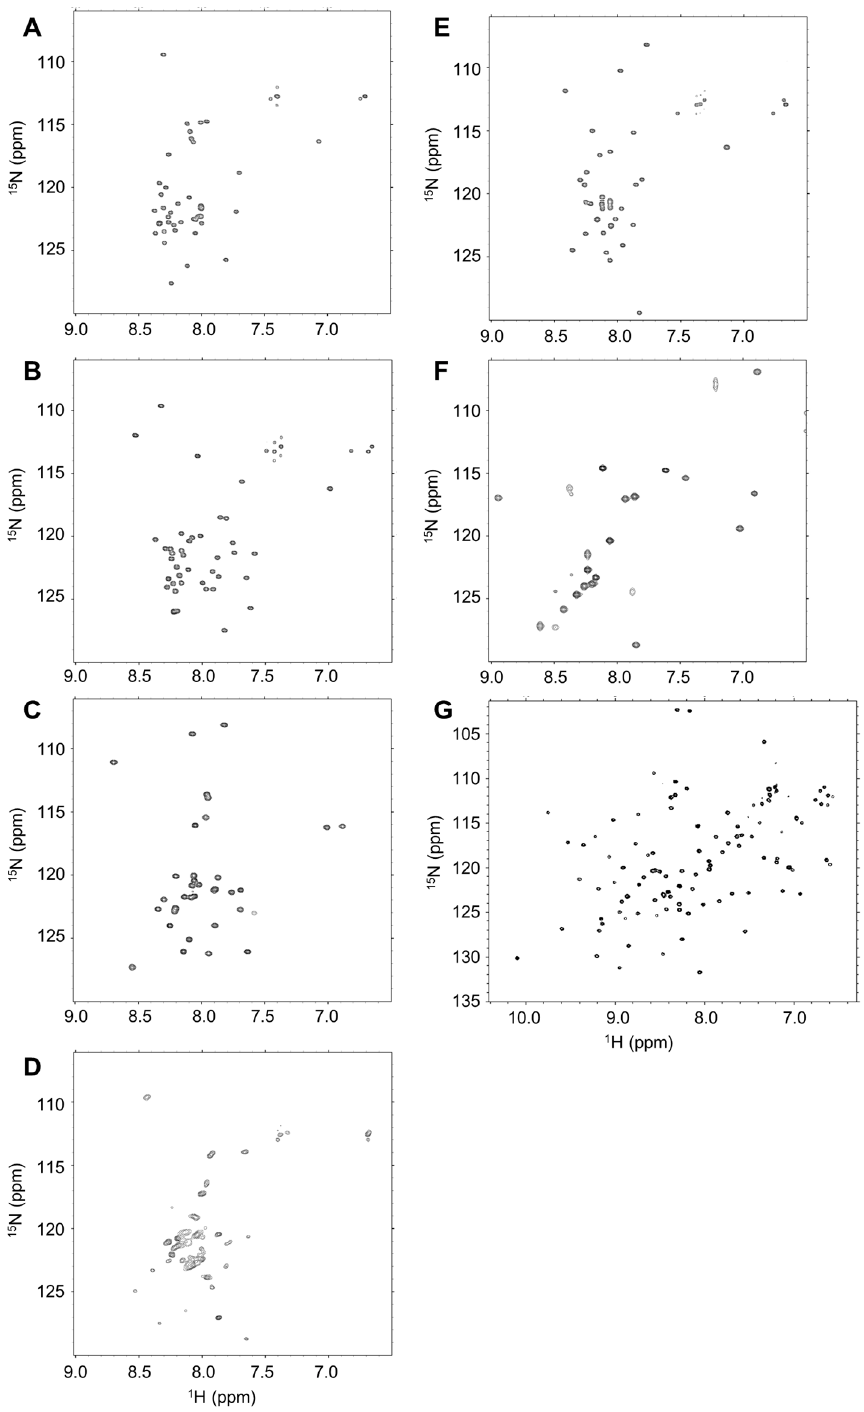
Figure 2. HSQC spectra of the selected human genome-derived IDP samples at 25 °C, pH 6.8. ( A ) IDP-B3; ( B ) IDP-B4; ( C ) IDP-C1; ( D ) IDP-D10; ( E ) IDP-E1; ( F ) IDP-C9 (example of the partly folded peptide); ( G ) mZO1-PDZ1 (example of the completely folded domain).